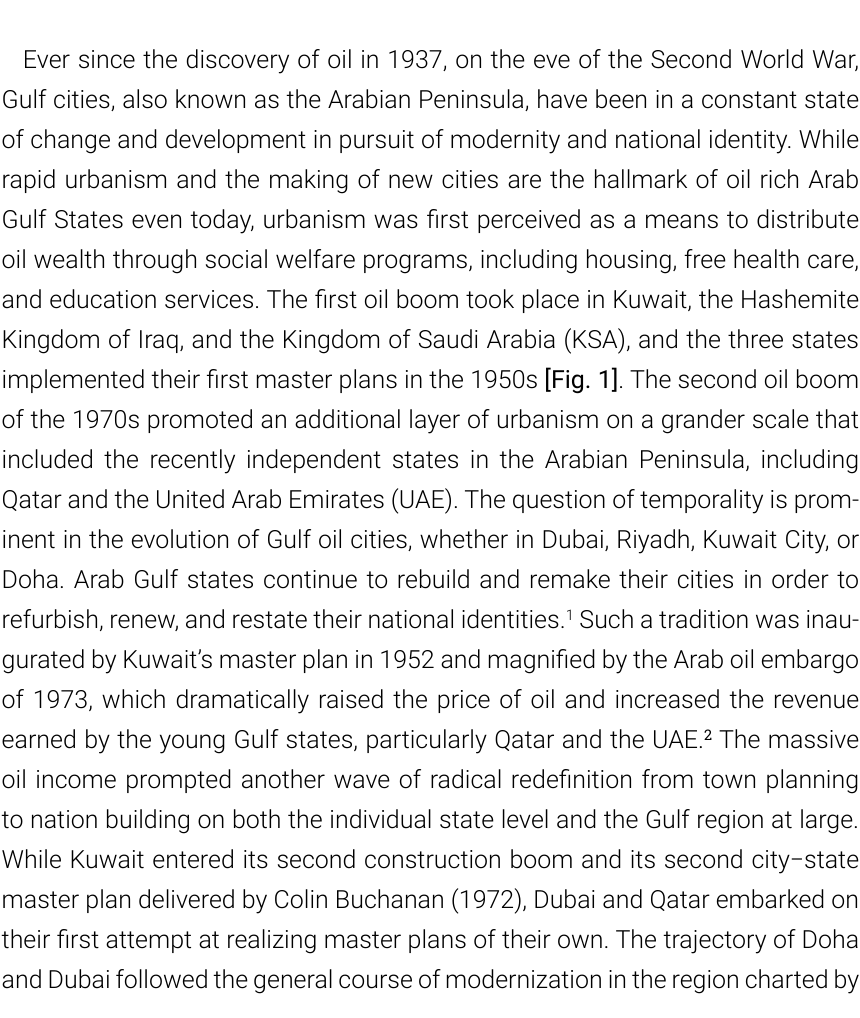
Fig. 1 Minoprio, Spencely, and Mac- farlane (MSM) Master Plan for Kuwait City (1952). Source: Shiber Archive, Wash- ington, DC. ©